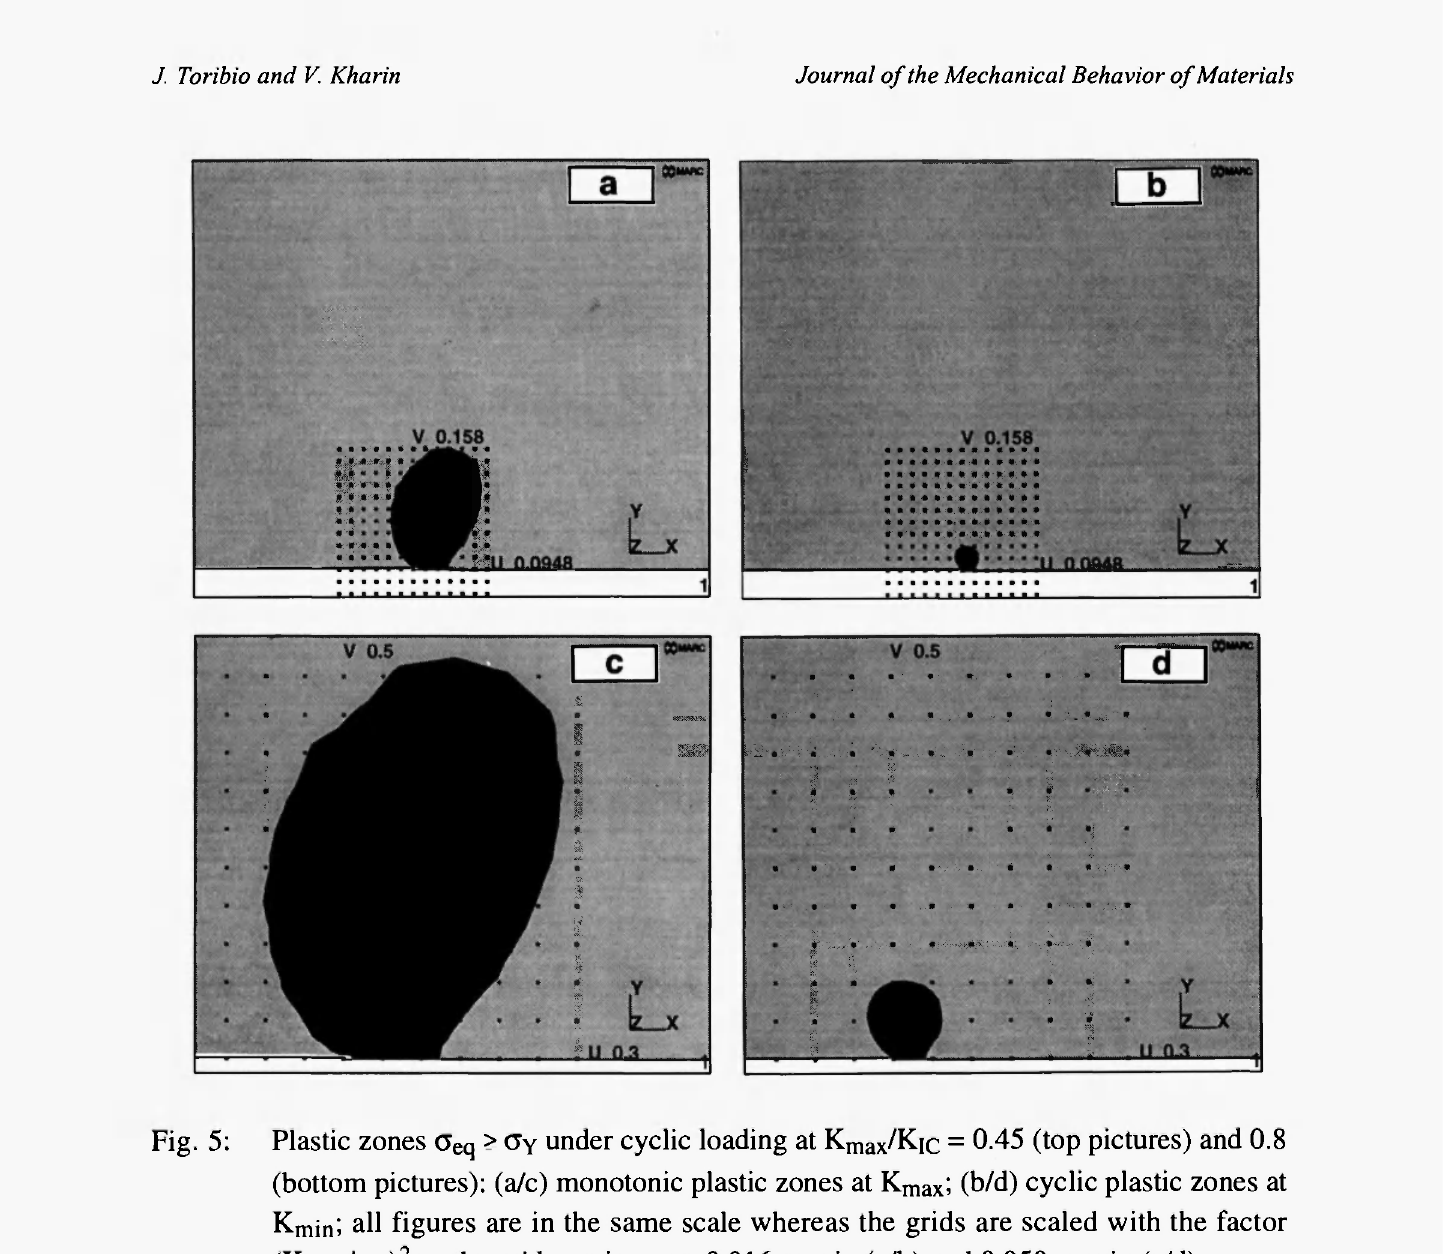
The reversed (cyclic) plastic zone at K i = 0 is also dependent on the previous K m n (or, in other words, on the range ΔΚ). For strain hardening materials, the criterion based on the tensile yield stress (a > σγ) is applicable to define the actual plastic flow zone only at the first eq forward loading marking the domain where plasticity ever occurred. Because of the material's hardening it is natural to define the plastic flow zone at cyclic loading from the condition